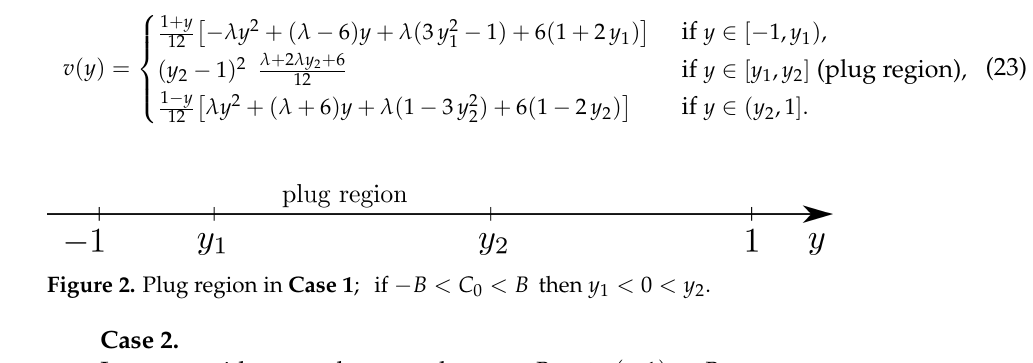
Figure 2. Plug region in Case 1 ; if − B < C 0 < B then y 1 < 0 < y 2 . Case